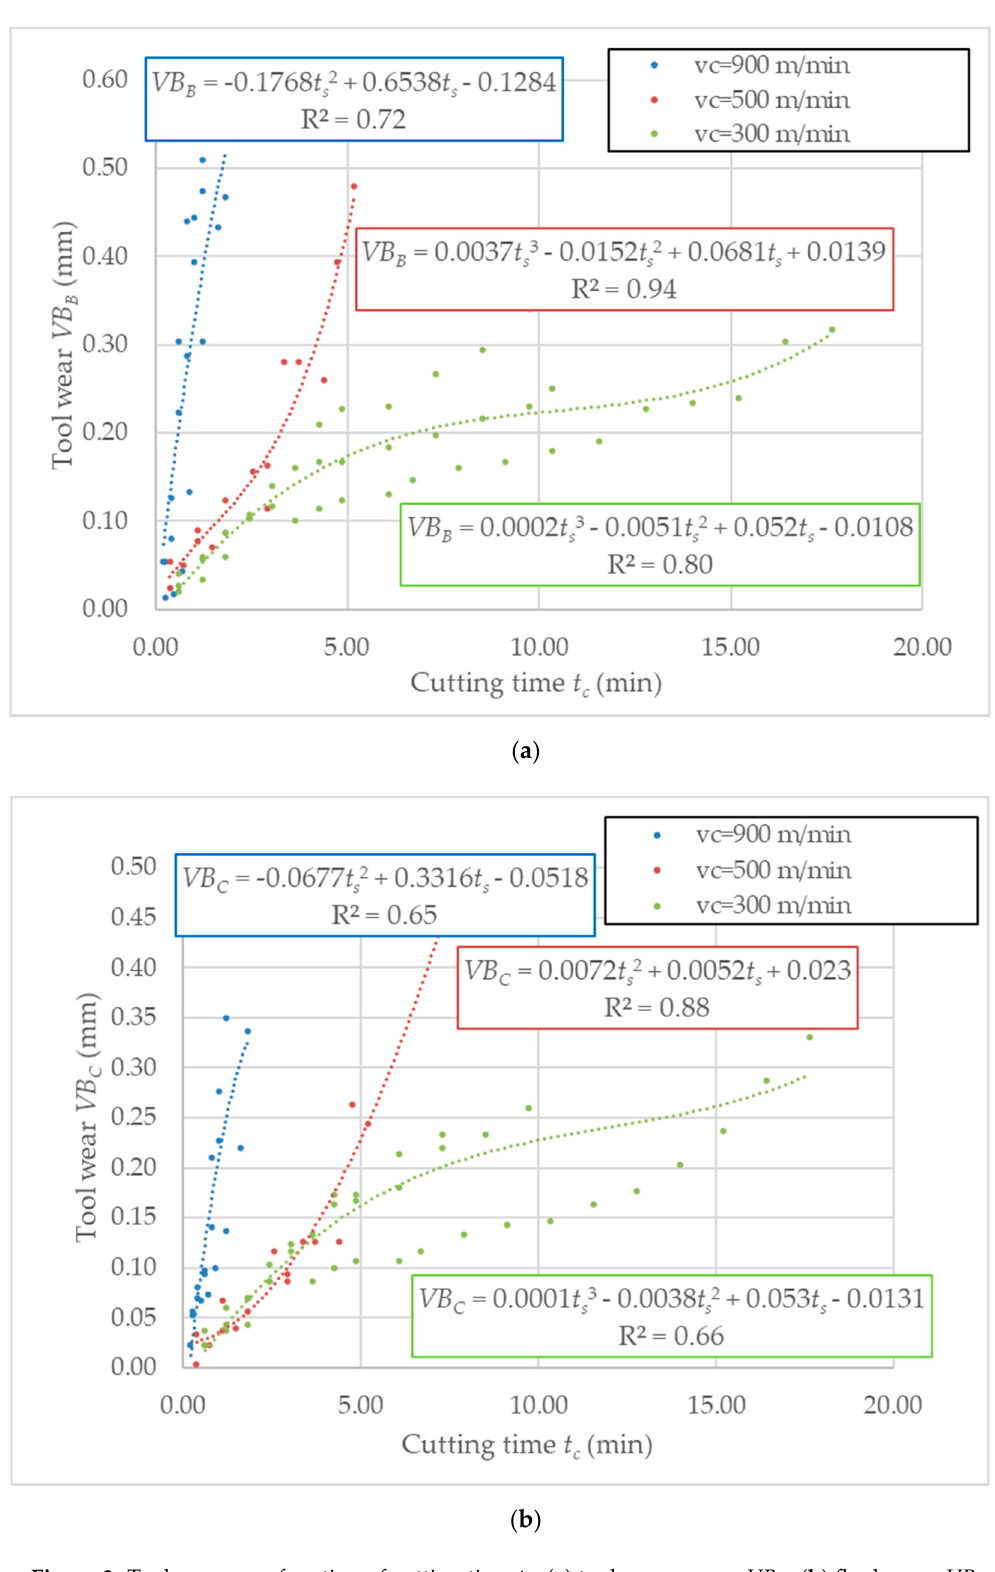
Figure 3. Tool wear, as a function of cutting time t s : ( a ) tool corner wear VB C , ( b ) flank wear VB B. Based on the determined equation, the average time needed for excessing the critical tool wear value has been calculated and shown in Table 6. Above this value, the unequal tool wear is caused by tool wear adhesion detected during AMC composite machining. Table 6. Average value of tool life for various cutting speed.